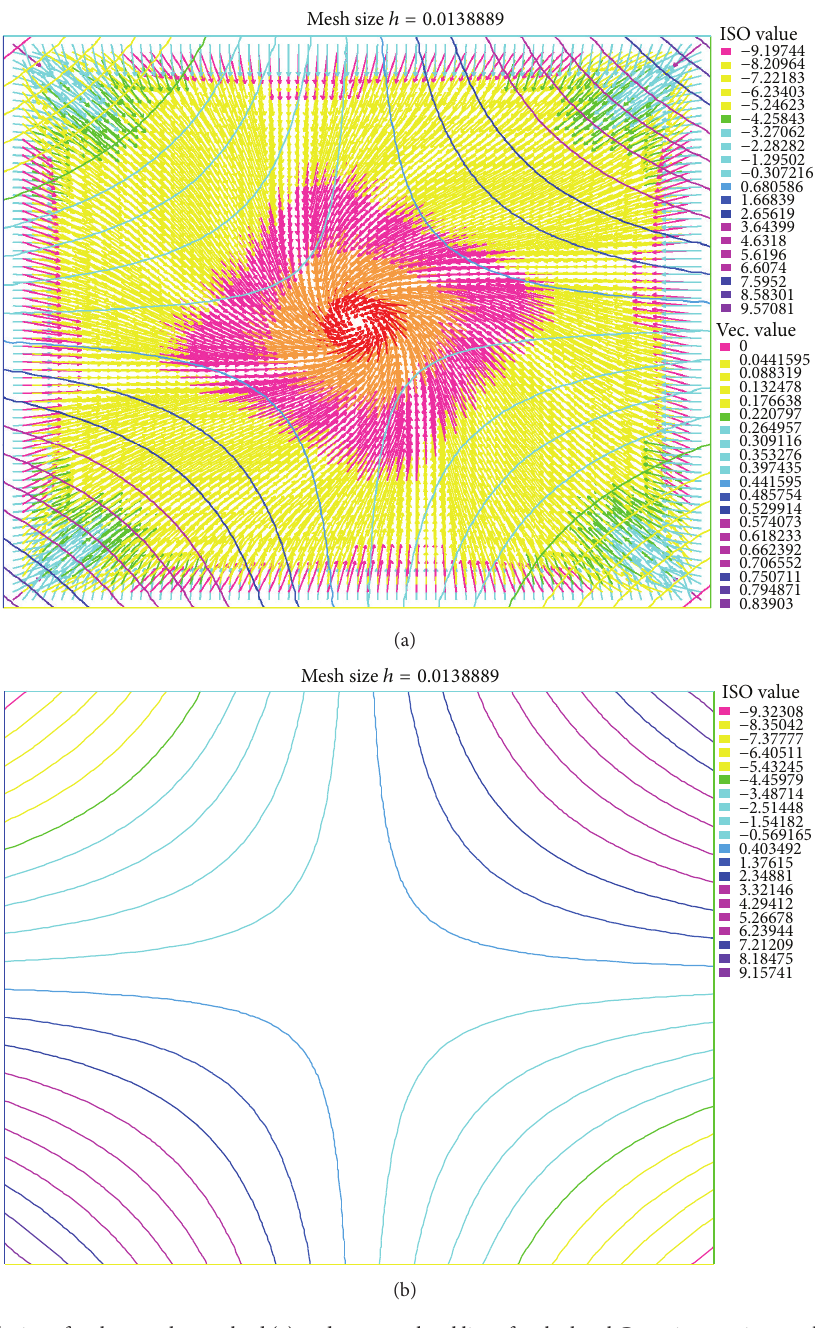
Figure 6: Numerical solutions for the penalty method (a) and pressure level lines for the local Gauss integration method (b) with 𝜀 = 1.0𝑒−4 , 𝛼 = 1.0𝑒 − 4 , and 𝑟 = 4 , respectively. Table 7: Results got from the local Gauss integration method with ] = 1.0𝑒 − 4 , 𝛼 = 1.0𝑒 − 4 , and 𝑟 = 3